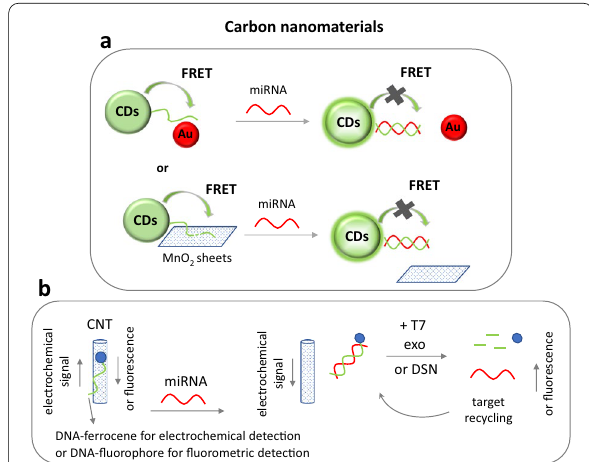
DNA-ferrocene for electrochemical detec(cid:31)on or DNA-fluorophore for fluorometric detec(cid:31)on Fig. 3 a Fluorescent carbon dots (CDs) coupled to a DNA probe are quenched by gold nanoparticles (Au) or MnO 2 nanosheets, phenomenon that is then hindered by hybridization of miRNA target. b DNA-carbon nanotubes with T7 exonuclease-assisted or DSN-assisted target recycling were used for the electrochemical or fluorometric detection of miRNA. CNT carbon nanotube, exo exonuclease, FRET fluorescence energy transfer, DSN duplex-specific